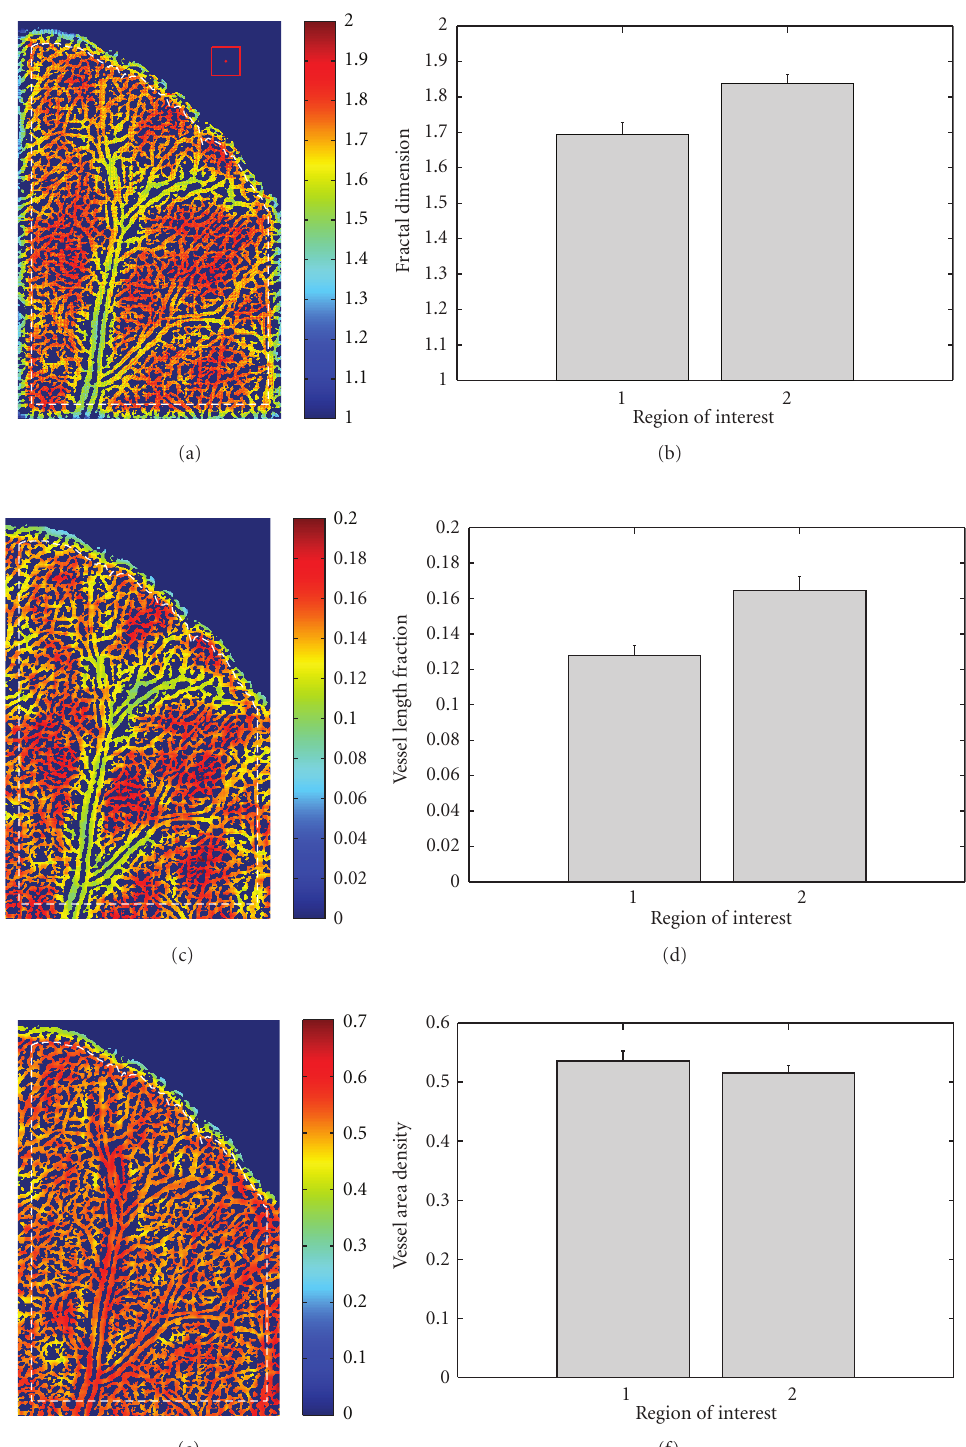
Figure 6: (a) Black and white segmented image multiplied by the (a) fractal dimension, (c) vessel length fraction, and (e) vessel area density of the OMAG image from day 1 (Figure 5(a)). Mean and standard deviation of the (b) fractal dimension, (d) vessel length fraction, and (f) vessel area density from the two regions of interests in Figure 5(a). The values were calculated with a 32 × 32 pixel length sliding window. The dashed lines in (a), (c), and (e) indicate the segmentation of the edges in the